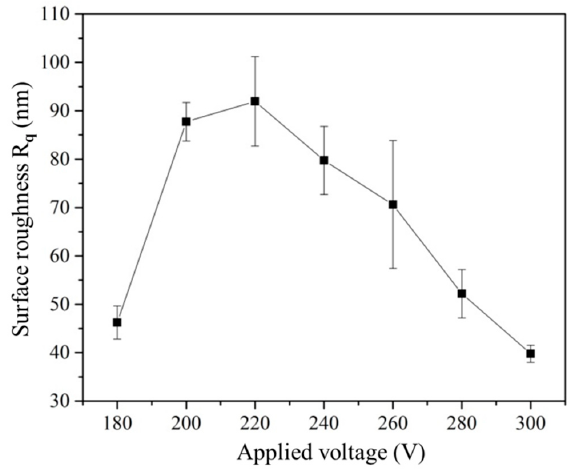
Figure 4. Surface roughness R q mean and standard deviation values with respect to the applied voltage when an electrode distance of 20 mm and the cathodic specimen speed of 0.25 mm/s are fixed.